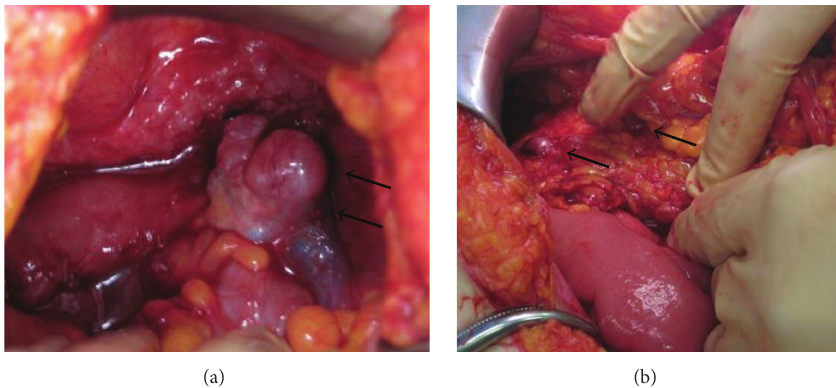
Figure 4: During surgery, a cystic lesion of 2-3 cm in the right ovary and ascites were noted (a → ). Also, intra-abdominal and omentum metastatic lesions were observed (b →